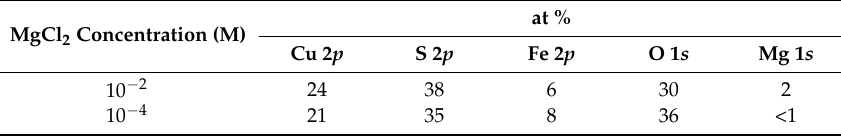
Table 1. Elemental composition of floated chalcopyrite surface.